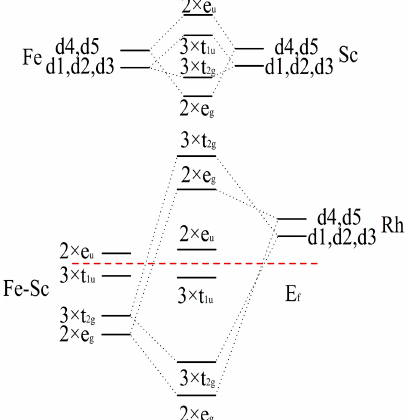
Figure 5. d -Orbit hybridization of the Rh (4 d ) and Fe/Sc (3 d ) transition elements in the ScFeRhP EQH compound.